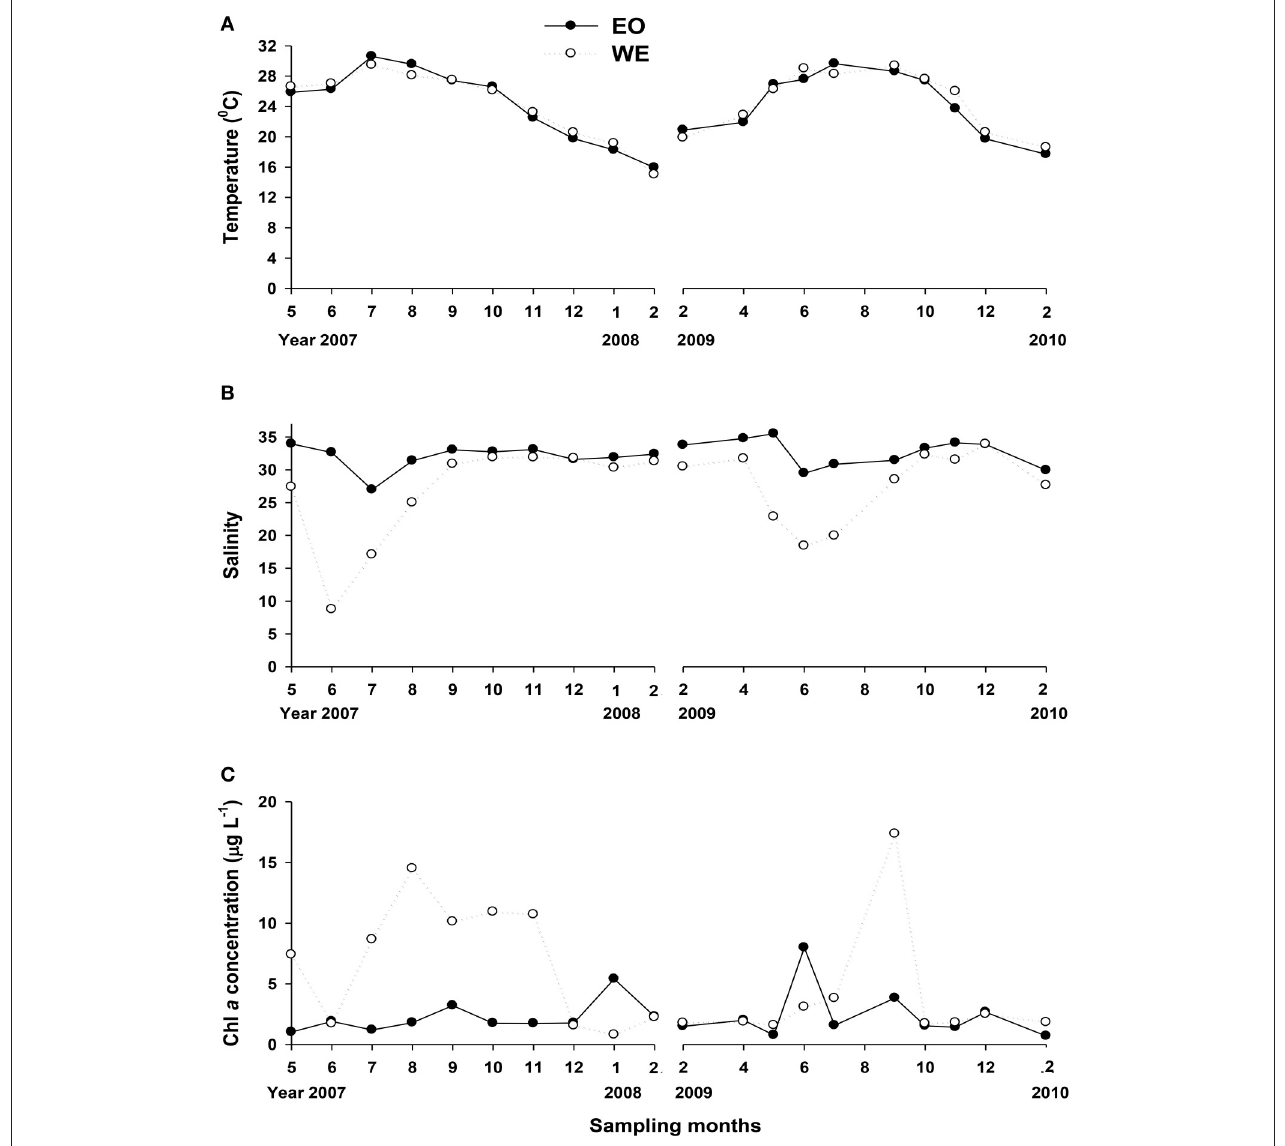
FIGURE 2 | Temporal variation in environmental variables in Hong Kong coastal waters: (A) temperature, (B) salinity and (C) Chl a